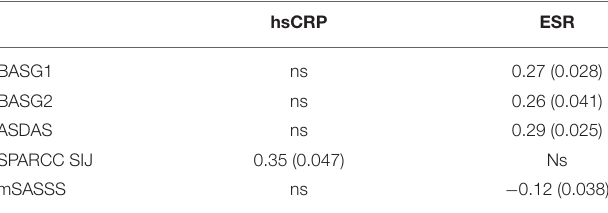
TABLE 3 | Correlations between hsCRP, ESR and clinical indices and imaging